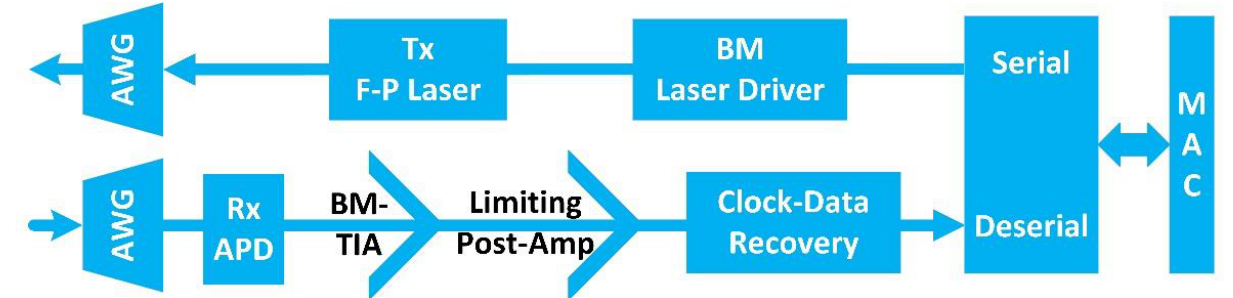
Figure 9. Typical OLT/ONU/ONT block diagram of TWDM-PON. Power saving is achieved at the expense of system complexity. In power-saving mode, ONU and ONT may lose their connectivity to the physical layer, especially in sleep mode. To hide it from the service level, the complexity of the system must be significantly increased. Software-based techniques employing effective mechanisms can leverage the ONU/ONT capabilities for energy saving, by combining a hybrid cyclic/deep sleep enabled at ONUs/ONTs, a batch-mode transmission at OLT and ONUs/ONTs and a DBA [40]. Figure 10 qualitatively depicts the ONU/ONT energy consumption according to the basic mode of operation, shown in the horizontal axis [38]. Table 5 [39]. Table 5. A power consumption example which shows the impact of sleep